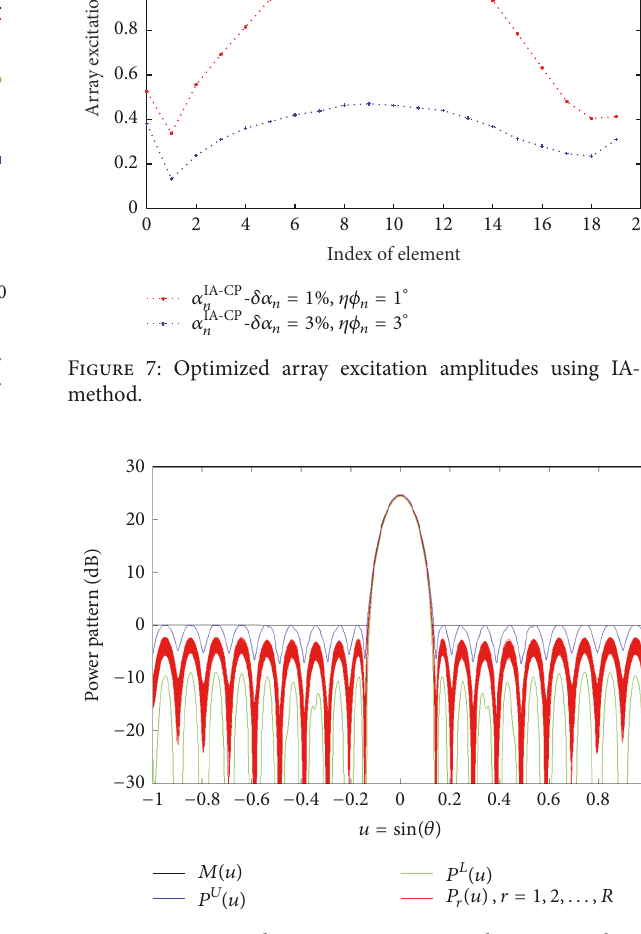
Figure 8: Array radiation patterns using the optimized array excitation ( 𝛿𝛼 𝑛 = 1 %, 𝜂 = 1 ∘ ).